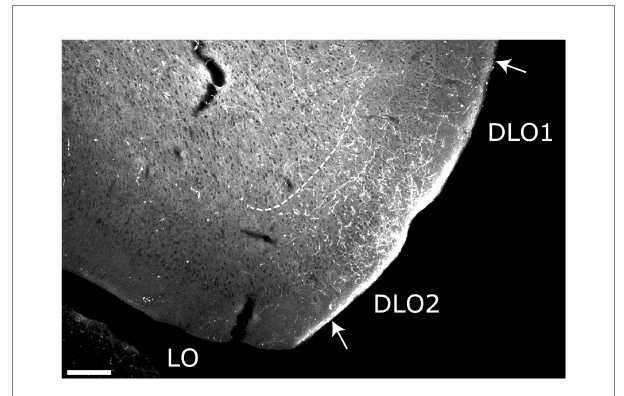
FIGURE 5 Image of a rostral section, visualizing the fiber projections to the dorsolateral orbital field (DLO) following a BDA injection in the dysgranular field (DI) of the anterior insular domain (case 16518B). Dense terminal labeling is present predominantly in superficial layers of the DLO2 field. Dashed lines indicate the border between layers 3 and 5. LO, lateral orbital field. Scale bars equal 200 μ